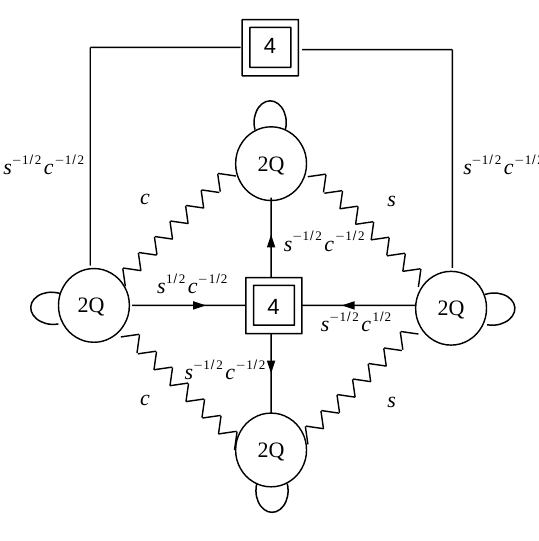
Figure 18: Gluing 2 n ( 1,1,1,1,0,0,0,0 ) tubes we obtain a torus with z = n units